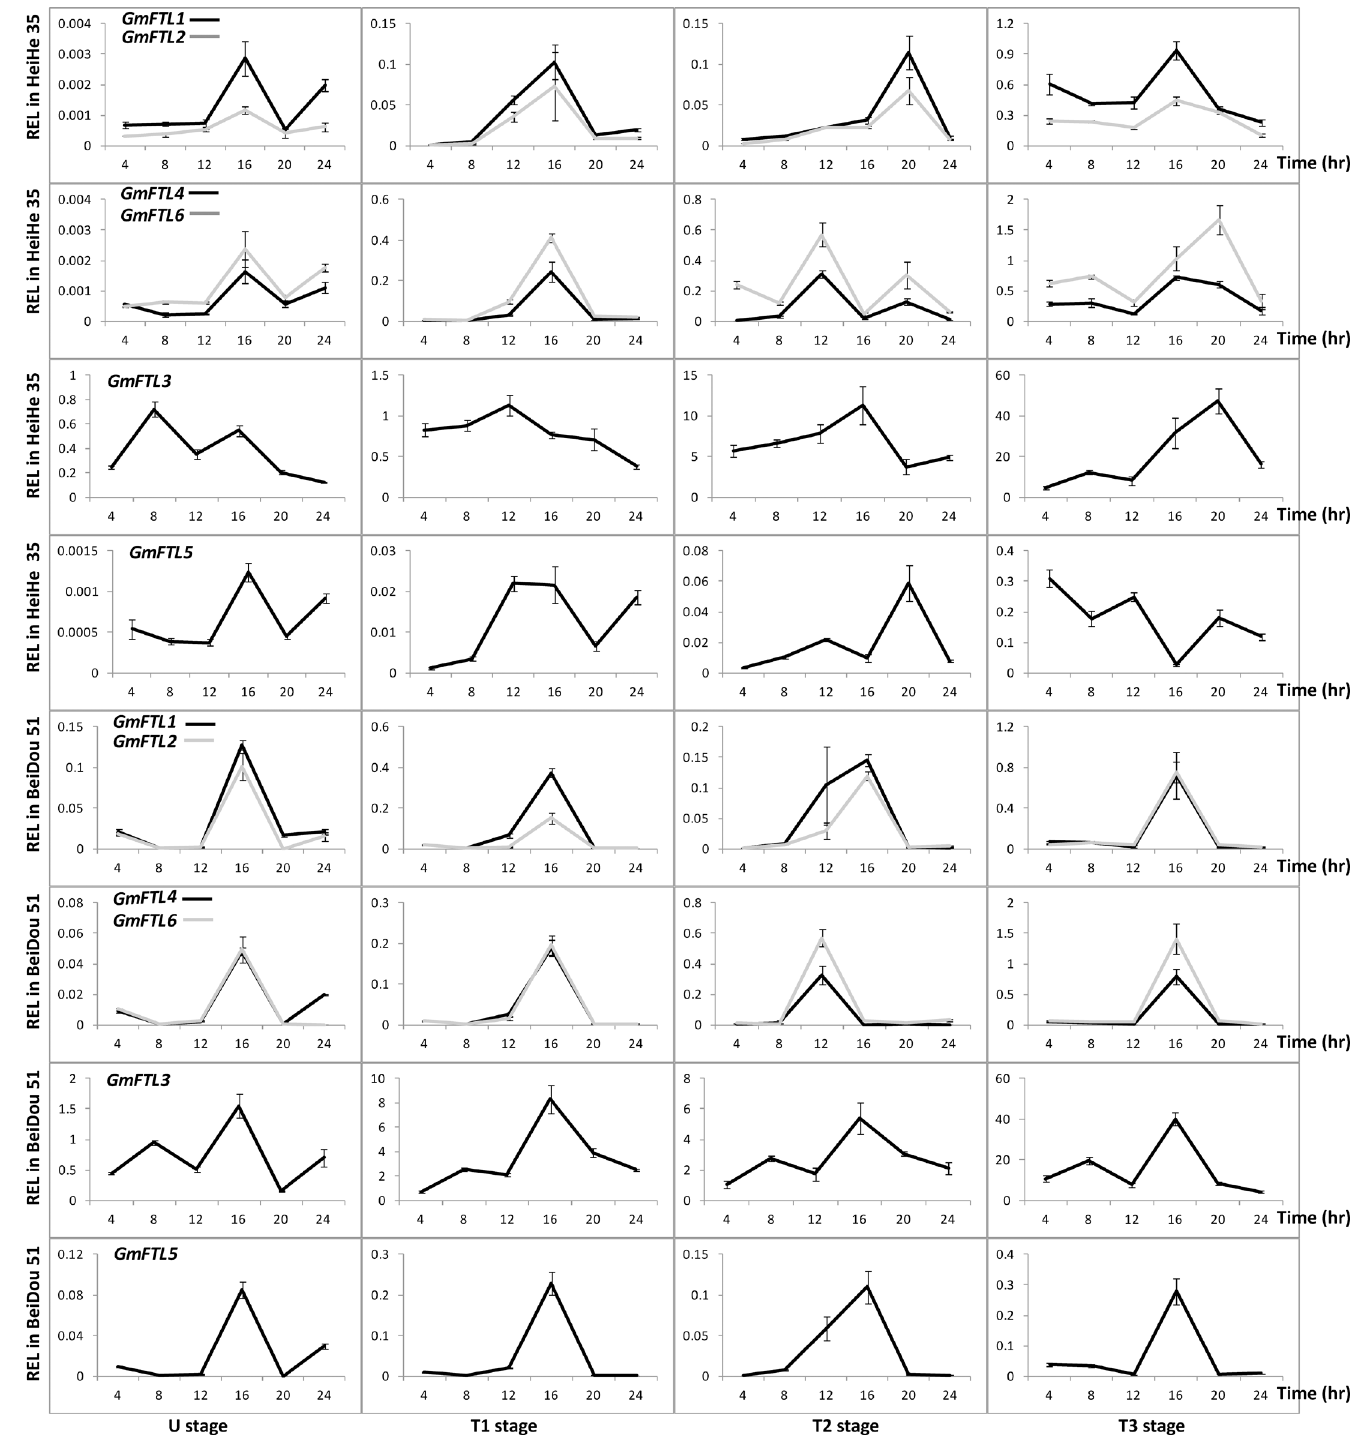
Fig 5. The diurnal rhythm of GmFTL expression in cultivars Heihe 35 and Beidou 51 at different stages. Relative expression levels (REL) were analyzed by RT-qPCR and normalized to UKN1 . Averages and standard errors are the result of three replicates. For detailed information on stages and sampling, see Materials and Methods